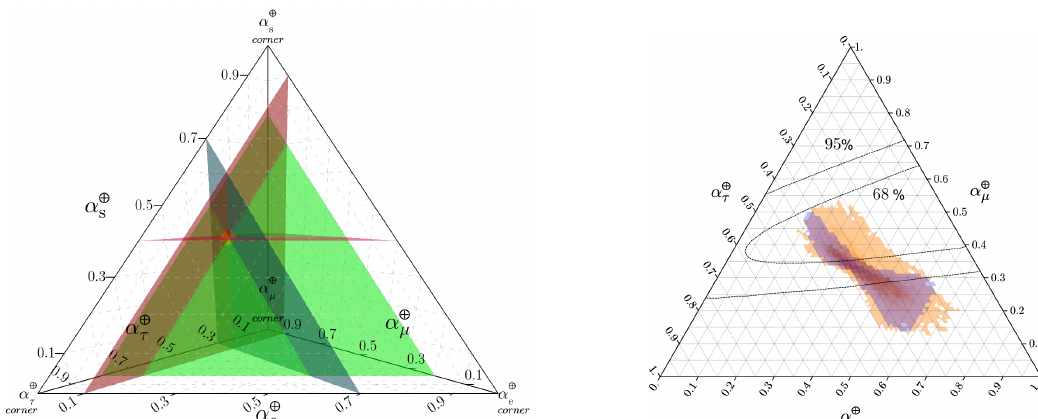
Figure 5. Left : a schematic view of how a new sterile state will contribute in to the flavor composition. The distance of every point inside the tetrahedron to the vertexes or the equivalently to the opposite faces will add to one and, therefore, be a good representation for the flavor ratio with one extra sterile state. Right : Effect projected in the active states flavor triangle for the case imposing unitarity and without the constraint (for illustration, the contours measured by IceCube are also included) [84]. Figure from